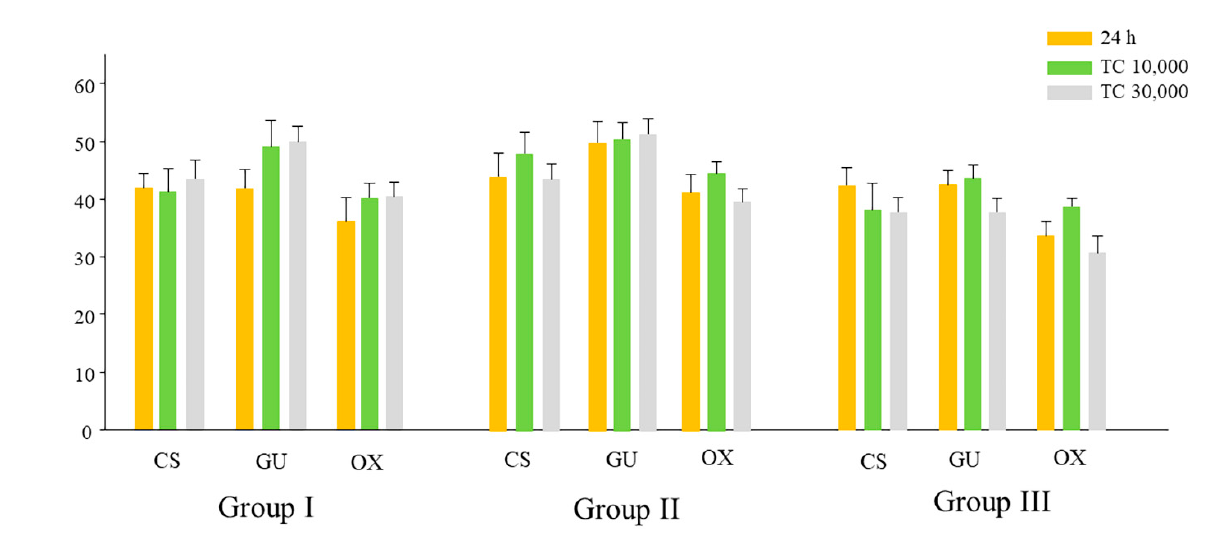
Figure 3. Influence of application method on enamel SBS (ER mode)